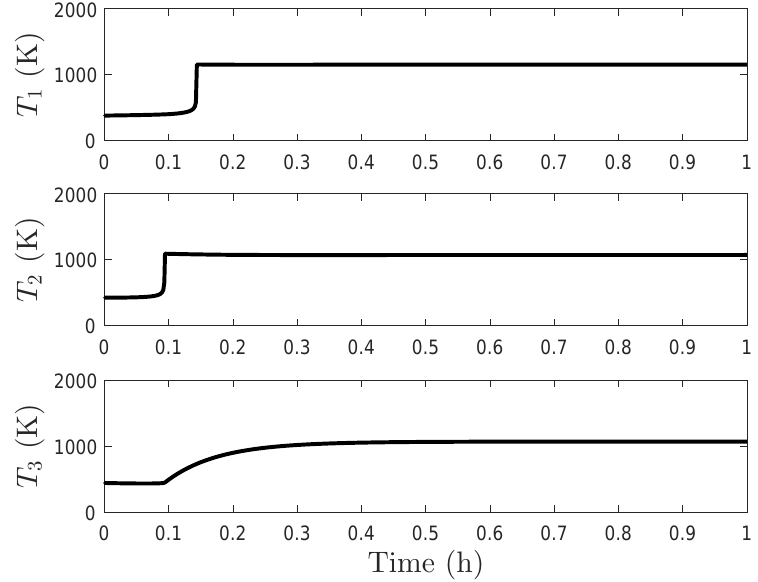
Figure 3. T 1 , T 2 , and T 3 over 1 h of operation for the 2 CSTR-flash drum process under a cyberattacked EMPC provided the false state measurement x F 1 = ¯ x u